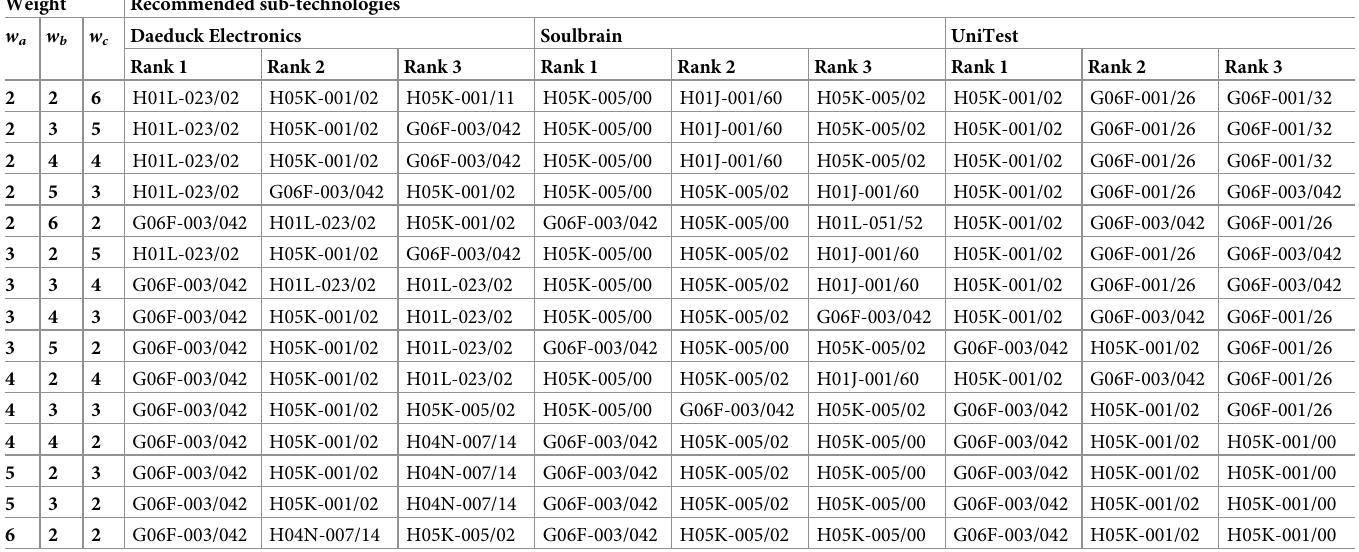
Table 8. Recommended sub-technologies by controlling weights. Weight Recommended